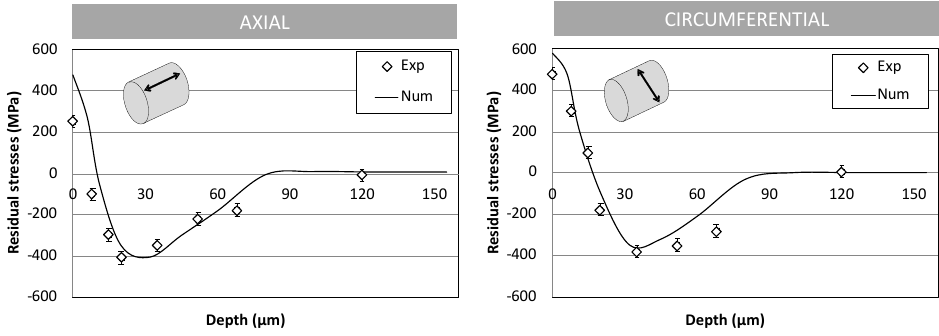
Figure 8. Comparison between experimental and numerical results.